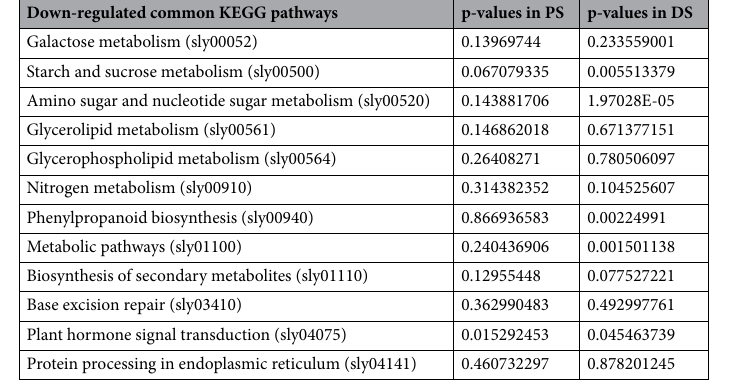
Table 2. Common pathways shared by PS and DS in KEGG enrichment analysis of down-regulated